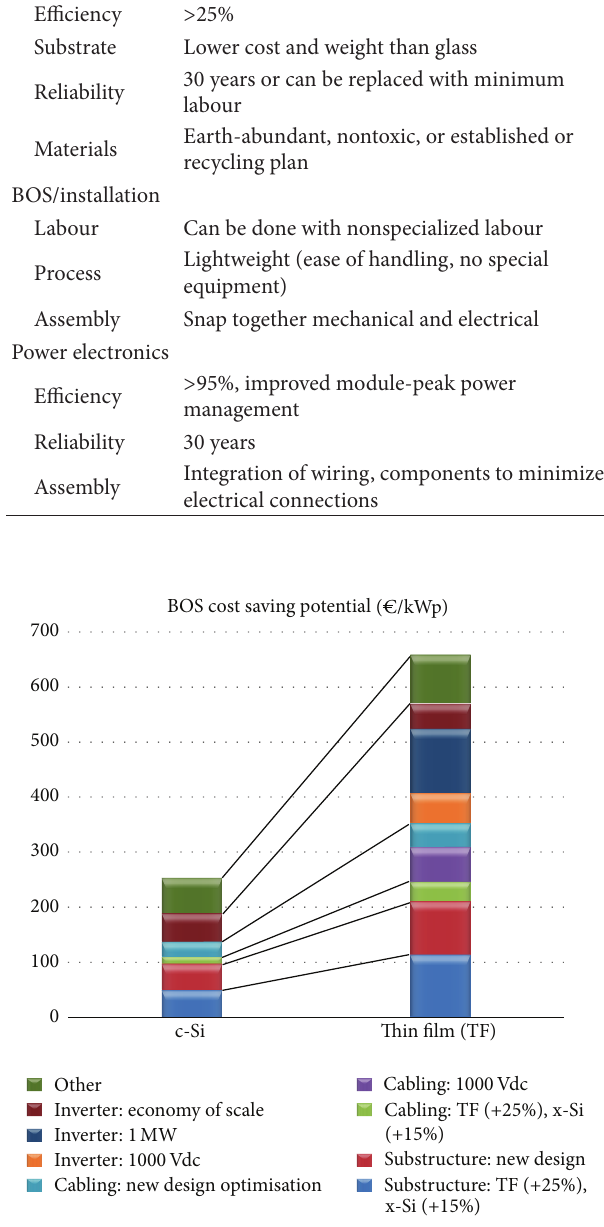
Figure 13: BOS cost saving potential in C/kWp for c-Si and TF modules